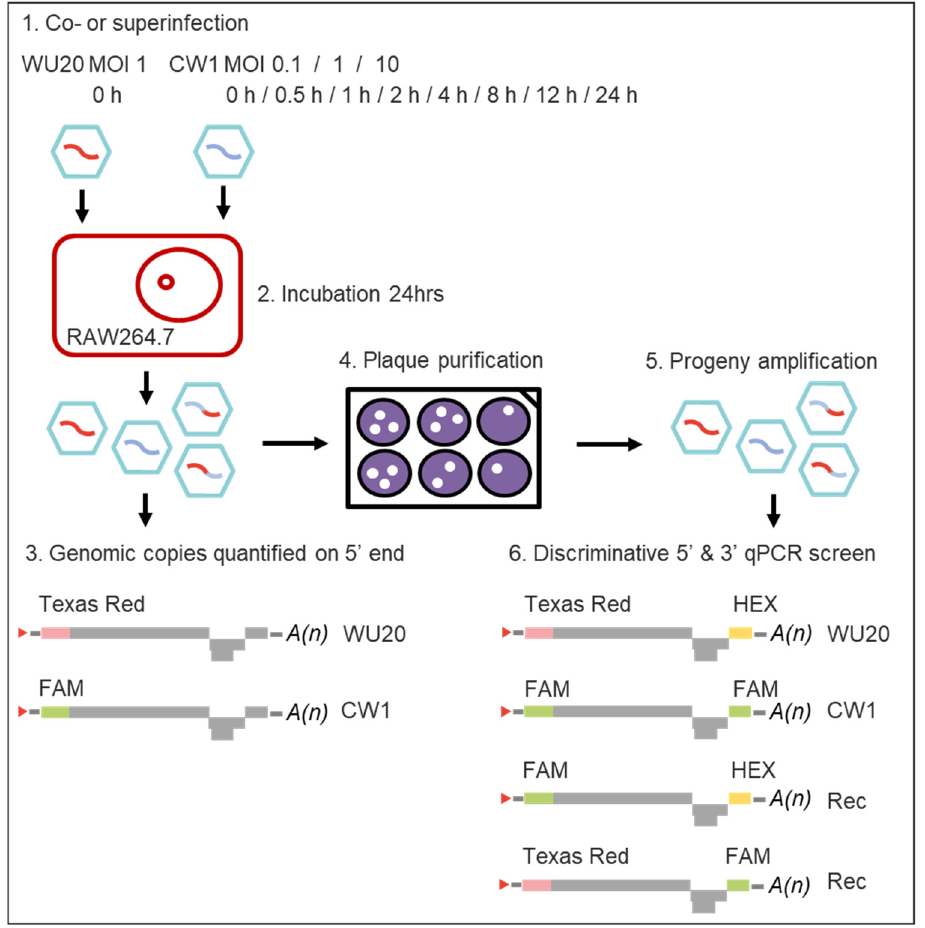
Figure 1. Workflow of the experimental set-up to analyse synchronous and asynchronous in vitro infections with homologous murine norovirus strains MNV-1 WU20 and CW1. MOI = Multiplicity of infection; ORF = Open Reading Frame; qPCR = quantitative polymerase chain reaction.